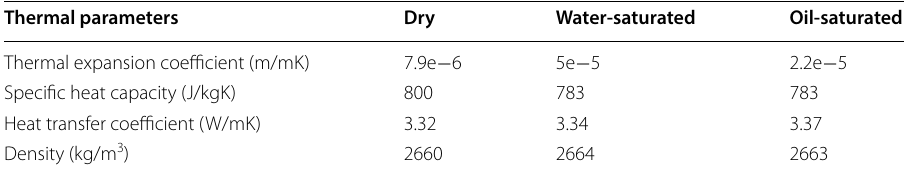
Table 4 Thermal parameters of granite Thermal parameters Dry Water-saturated